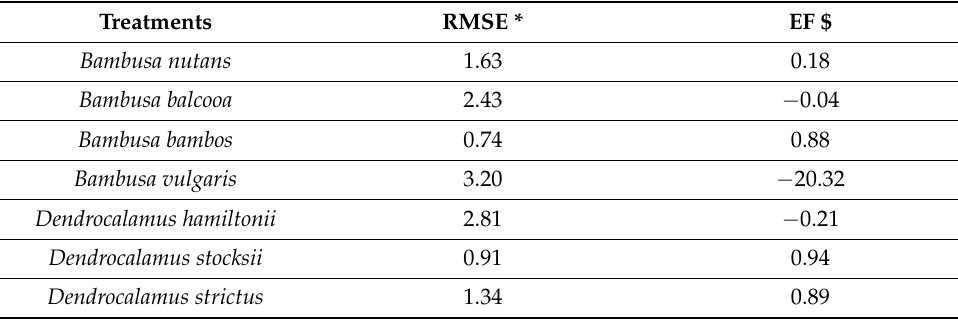
Table 2. Statistics describing performance of model for each